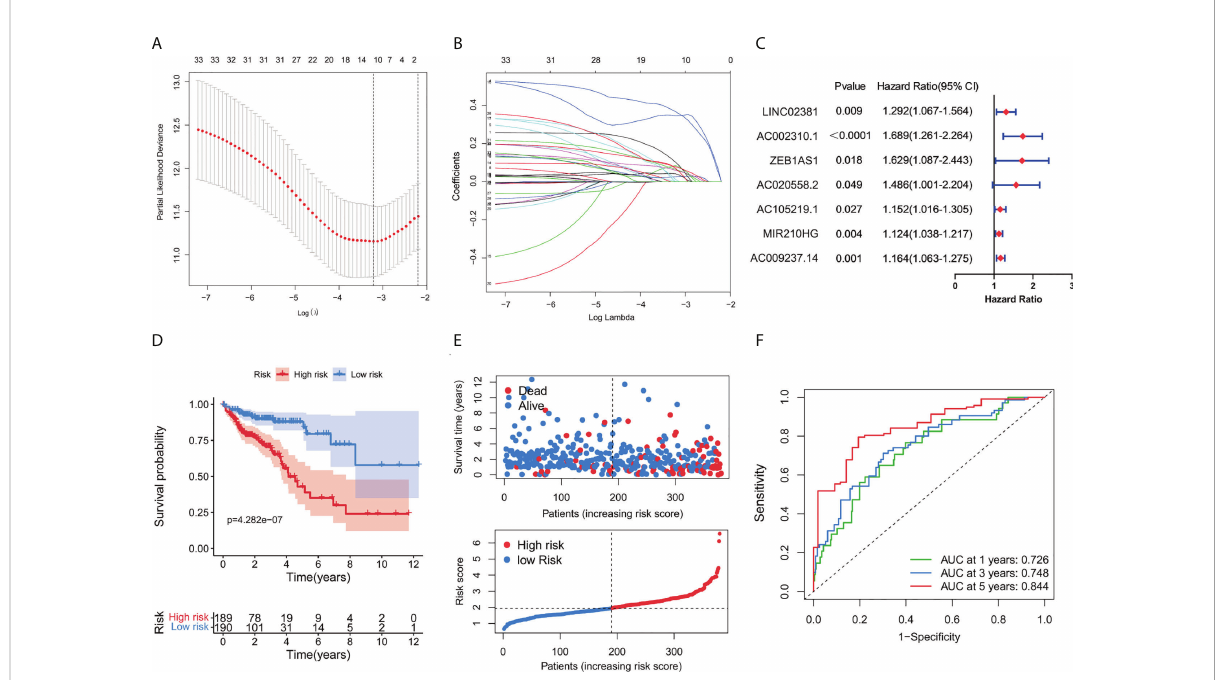
FIGURE 2 Construction of a prognostic GT-related lncRNA risk model. (A) Screening of optimal parameters (lambda) in the LASSO regression model. (B) LASSO coef fi cient pro fi les of 11 candidate GT-related lncRNAs. (C) Forest map of seven GT-related lncRNAs signi fi cantly correlated with outcome and identi fi ed by multivariate cox regression. (D) Kaplan – Meier curve for the OS of COAD patients in the high- and low-risk group. (E) Distribution of survival status and risk score in the patient cohort. (F) ROC curves at 1, 3, and 5 years in COAD